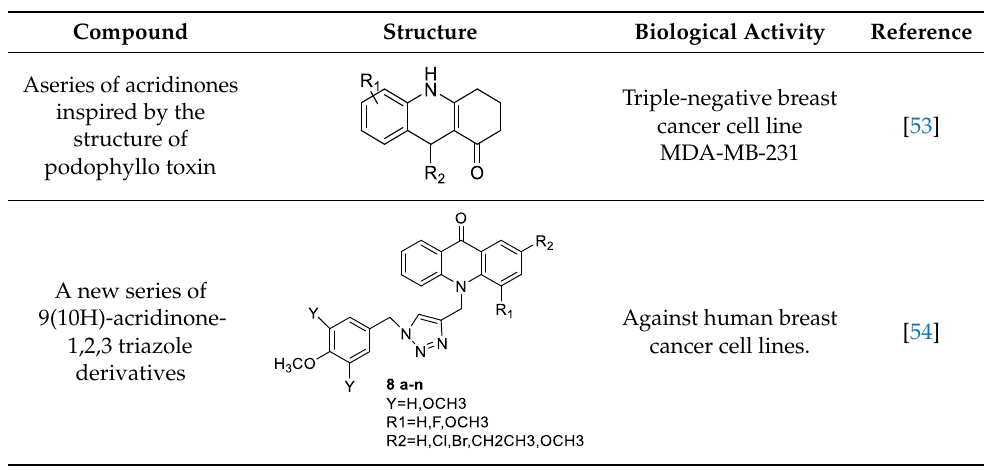
Table 6. Acridinone as an anti-tumour agent.